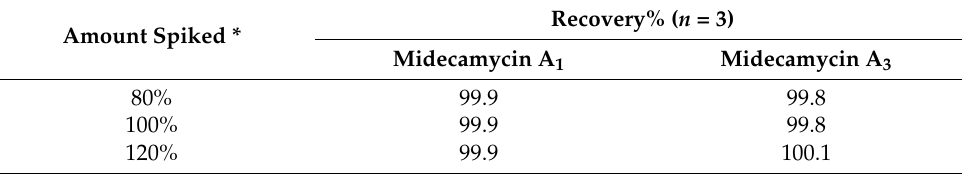
Table 3. Recovery of midecamycin A 1 and midecamycin A 3 by standard